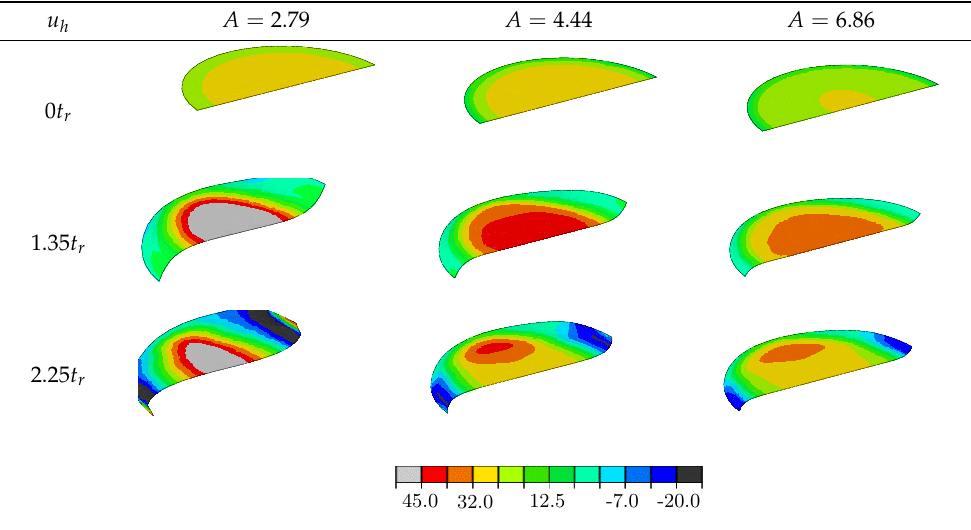
Figure 15. Influence of aspect ratio A on the axial stress S11 distribution in the carbon fiber reinforcement.